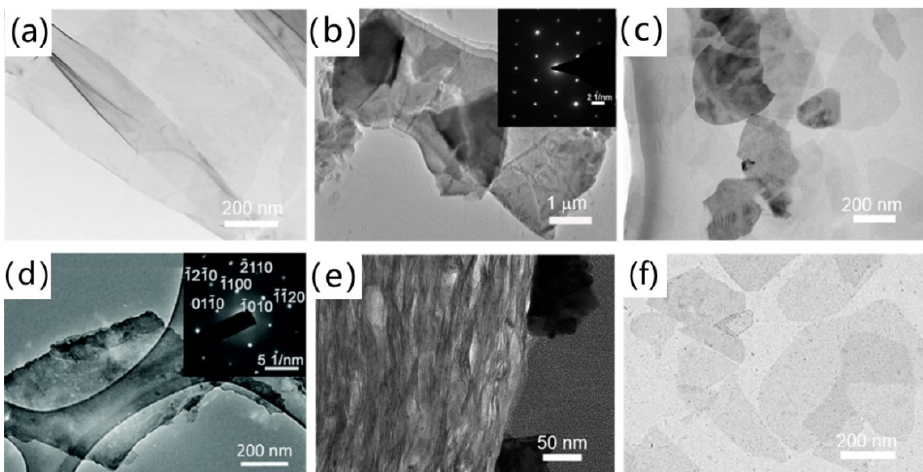
Fig. 16 Microstructure of MXene in TEM. (a) TEM image of Ti 3 C 2 T x MXene prepared by HCl/LiF. Reproduced with permission from Ref. [146], © American Chemical Society 2020. (b) TEM image of Ti 3 C 2 T x prepared by HF etching, (c) TEM image of Ti 3 C 2 T x obtained by etching submicron Ti 3 AlC 2 grains grown in molten salt, and (d) TEM image of Ti 4 N 3 T x . Reproduced with permission from Ref. [125], © Royal Society of Chemistry 2016. (e) The cross-sectional microstructure of Au anchored on Ti 3 C 2 T x membrane. Reproduced with permission from Ref. [147], © Elsevier 2020. (f) TEM image of Pt anchored on Ti 3 C 2 T x nanosheet. Reproduced with permission from Ref. [148], © WILEY-VCH Verlag GmbH & Co. KGaA, Weinheim,